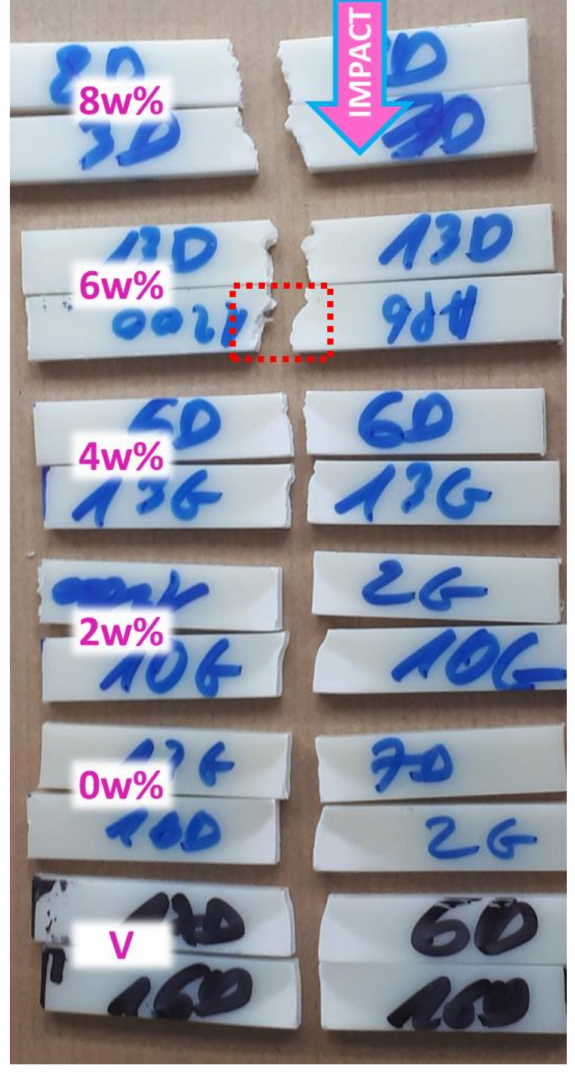
Figure 3. Picture of unnotched Charpy impact broken specimens of ABS gradually contaminated with PP—arrow shows direction of impact; rectangle points out dephasing at